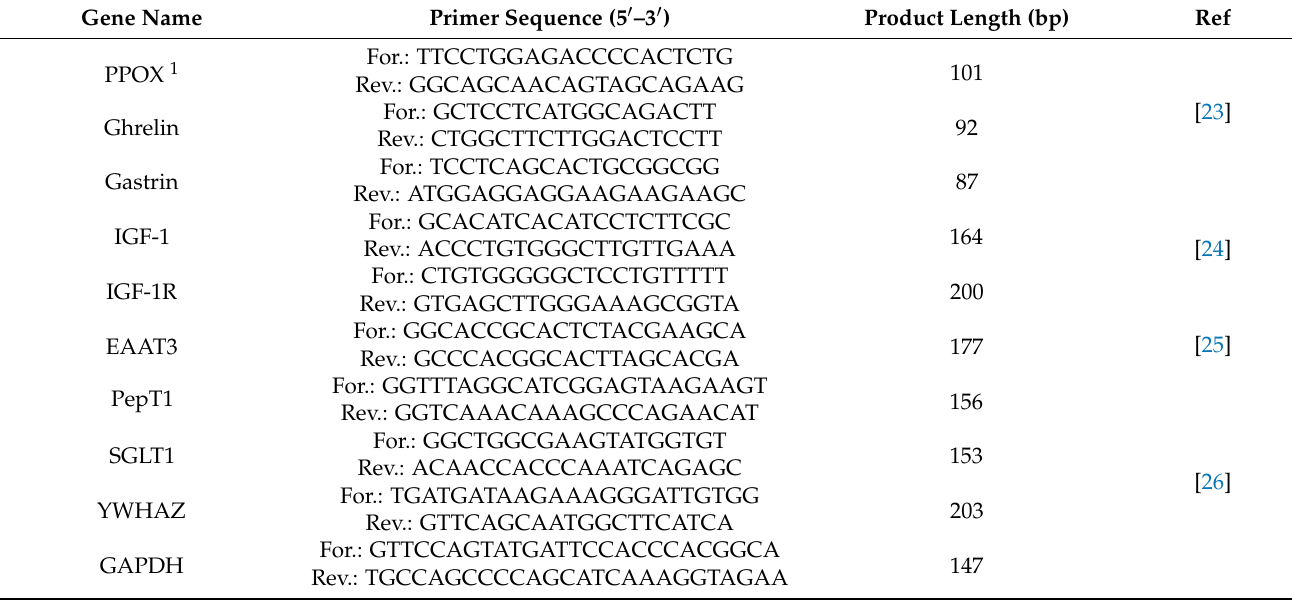
Table 2. List of primers used for quantitative